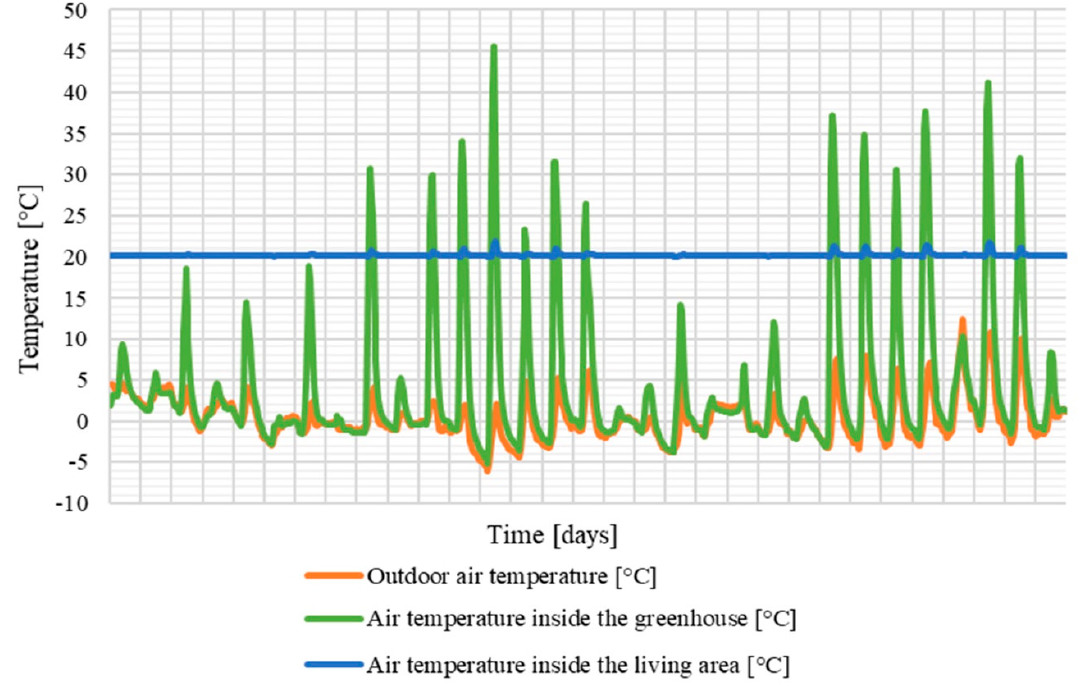
Figure 7. Trend of outdoor air temperatures (orange), inside the living area (blue) and the greenhouse (green) for the month of January.